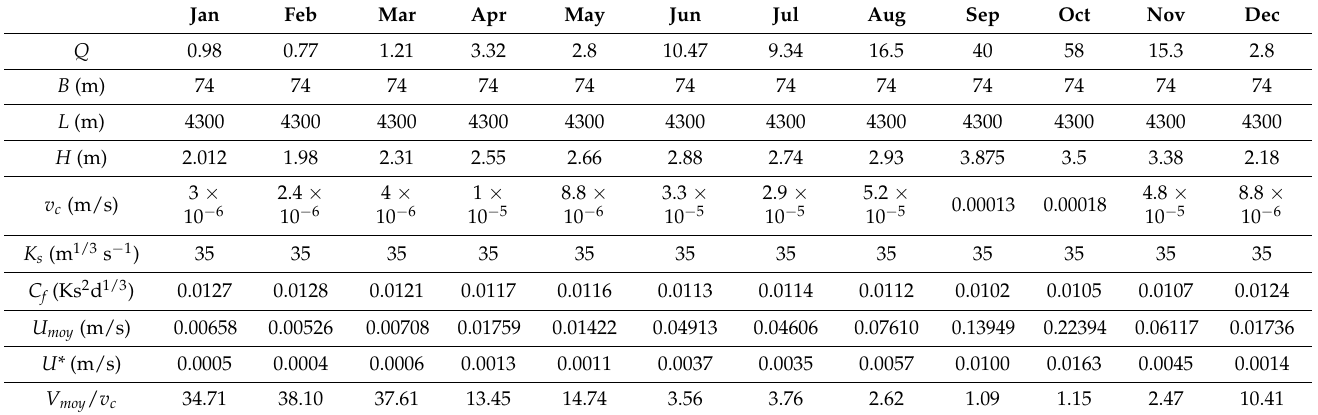
Table 3. Hydrodynamic parameters of the Lobo reservoir models.